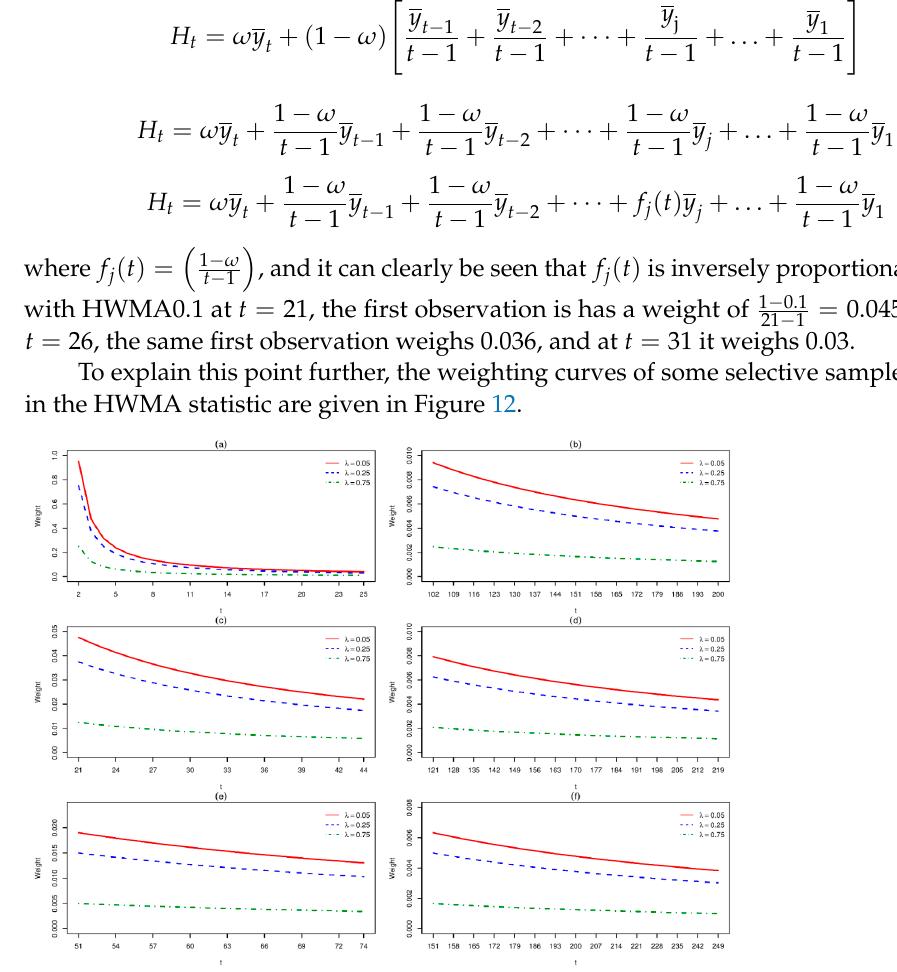
Figure 12. Weight assessment of HWMA with respect to time points (𝑡) for ( a , b ) the first value under zero state and steady state performances, respectively; ( c , d ) the 20th value under zero state and steady state performances, respectively; ( e , f ) the 50th value under zero state and steady state performances, respectively. Figure 12a contains the weight given to first sample in the calculation of the HWMA statistic ( 𝐻 (cid:3047) ) ∀ 𝑡 = 2,3,…,25 . It can be seen further into the future, the weight given to the